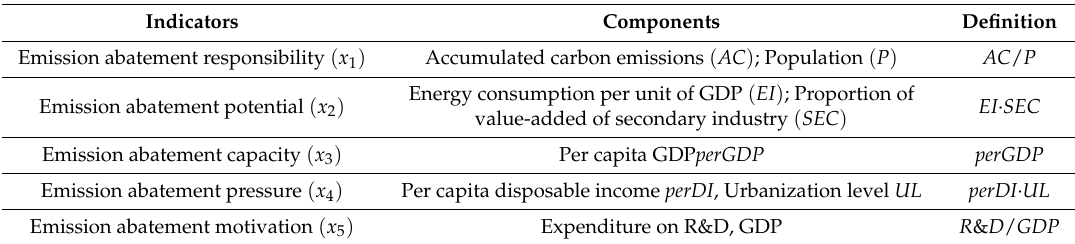
Table 1. Five indicators describing the carbon emission